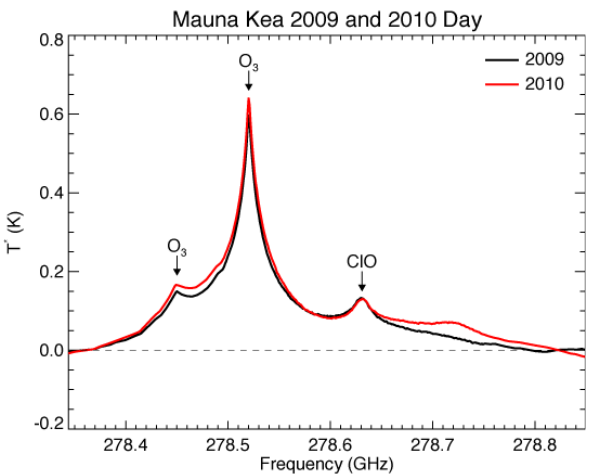
Figure 1 507 Fig. 1. Average daytime spectra in 2009 and 2010.